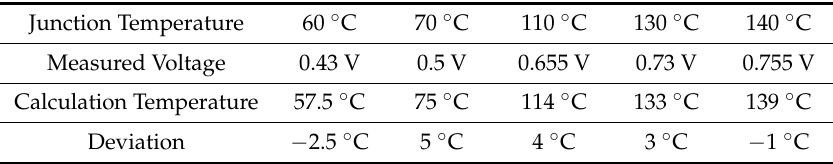
Figure 17. Measurement circuit output waveforms at different temperatures. Table 1. The measured voltage by the measuring circuit at different temperatures and the temperature calculated by using Equation (13).